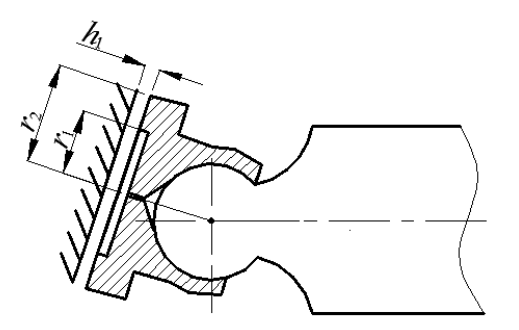
Figure 5. The swash plate and slipper.